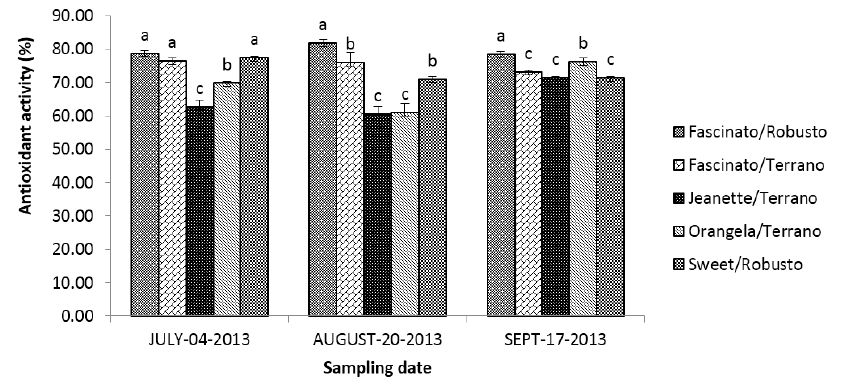
Figure 11. Antioxidant activity of grafted bell pepper varieties harvested in three different sampling dates. a–d Different letters indicate statistical difference ( p ≤